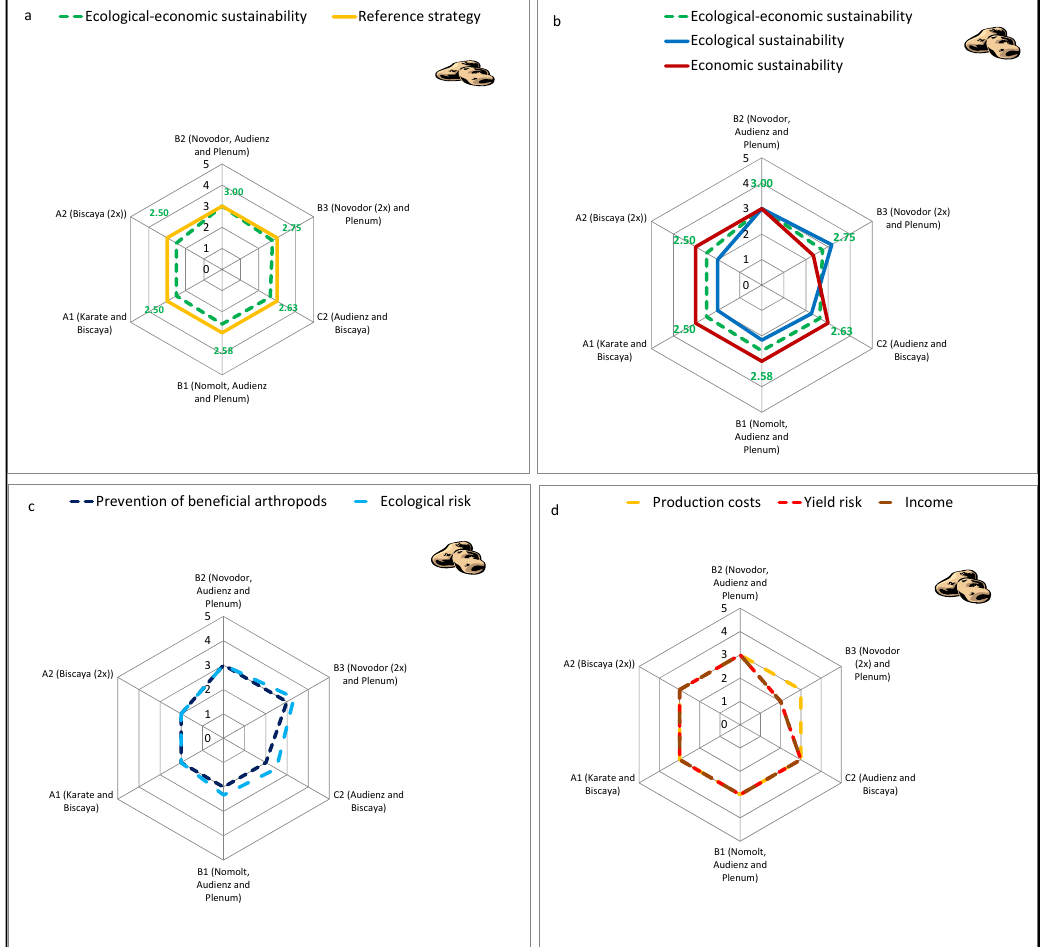
Figure 3. Results of the sustainability assessment of different plant protection strategies for the control of Colorado potato beetles and potato aphids compared to the reference strategy using Audienz (spinosad) and Plenum (pymetrozine). 1 = Much worse than RS; 2 = Worse than RS; 3 = Similar to RS; 4 = Better than RS; 5 = Much better than RS; RS = Reference